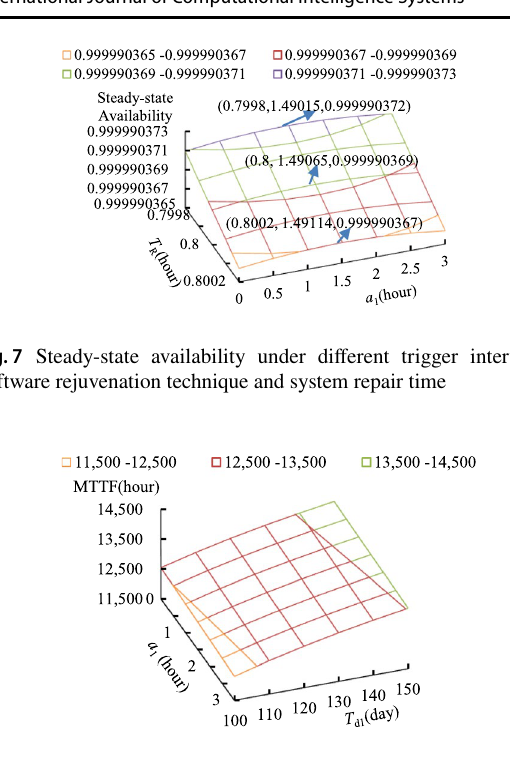
Fig. 8 MTTF under different trigger intervals of software rejuvena- tion technique and VNF failure time